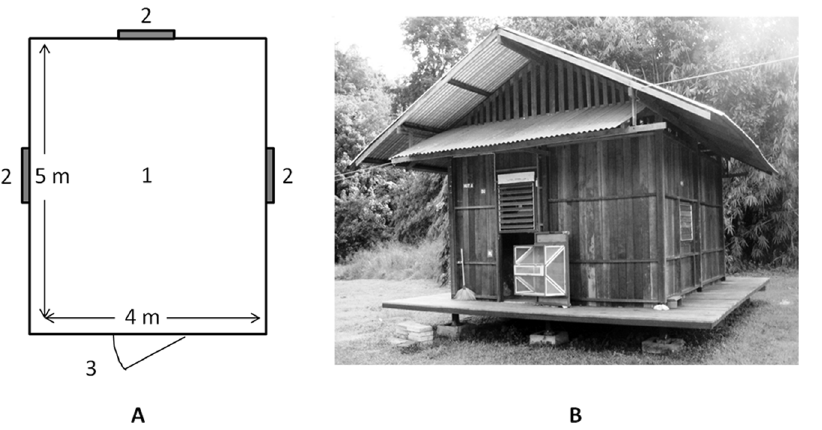
Figure 2. Diagram (A) and picture (B) of experimental huts. The sampling pumps were placed on 1.5 m tall stands in the approximate center of each hut ( # 1 panel A). Each hut had three screened windows ( # 2 panel A) and one screened door ( # 3 panel A) allowing air into the hut from the outside.